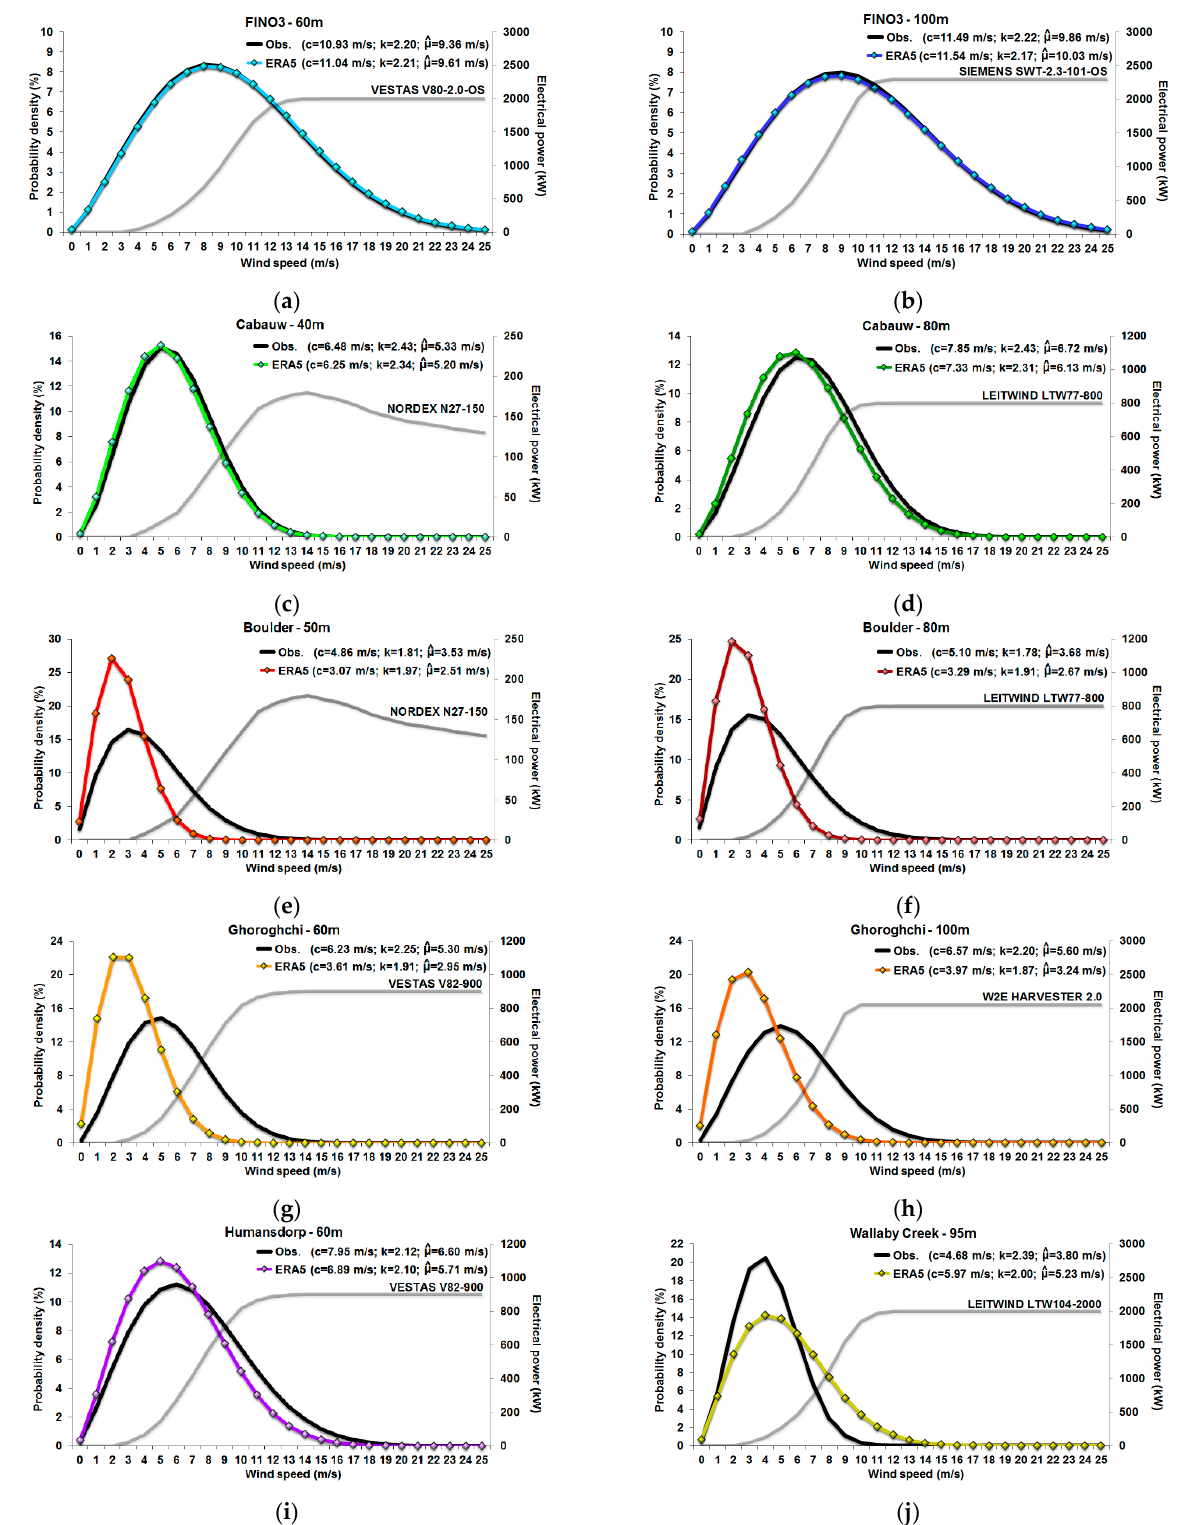
Figure 3. Weibull distribution of annual wind speed observed vs. estimated at: ( a ) FINO3 60 m; ( b ) FINO3 100 m; ( c ) Cabauw 40 m; ( d ) Cabauw 80 m; ( e ) Boulder 50 m; ( f ) Boulder 80 m; ( g ) Ghoroghchi 60 m; ( h ) Ghoroghchi 100 m; ( i ) Humansdorp 60 m; and ( j ) Wallaby Creek 95 m. Scale ( c ) and shape ( k ) factors are also reported along with median wind speed ( 𝜇̂ ). Power curves of WTs used in wind energy yield calculation are also shown.